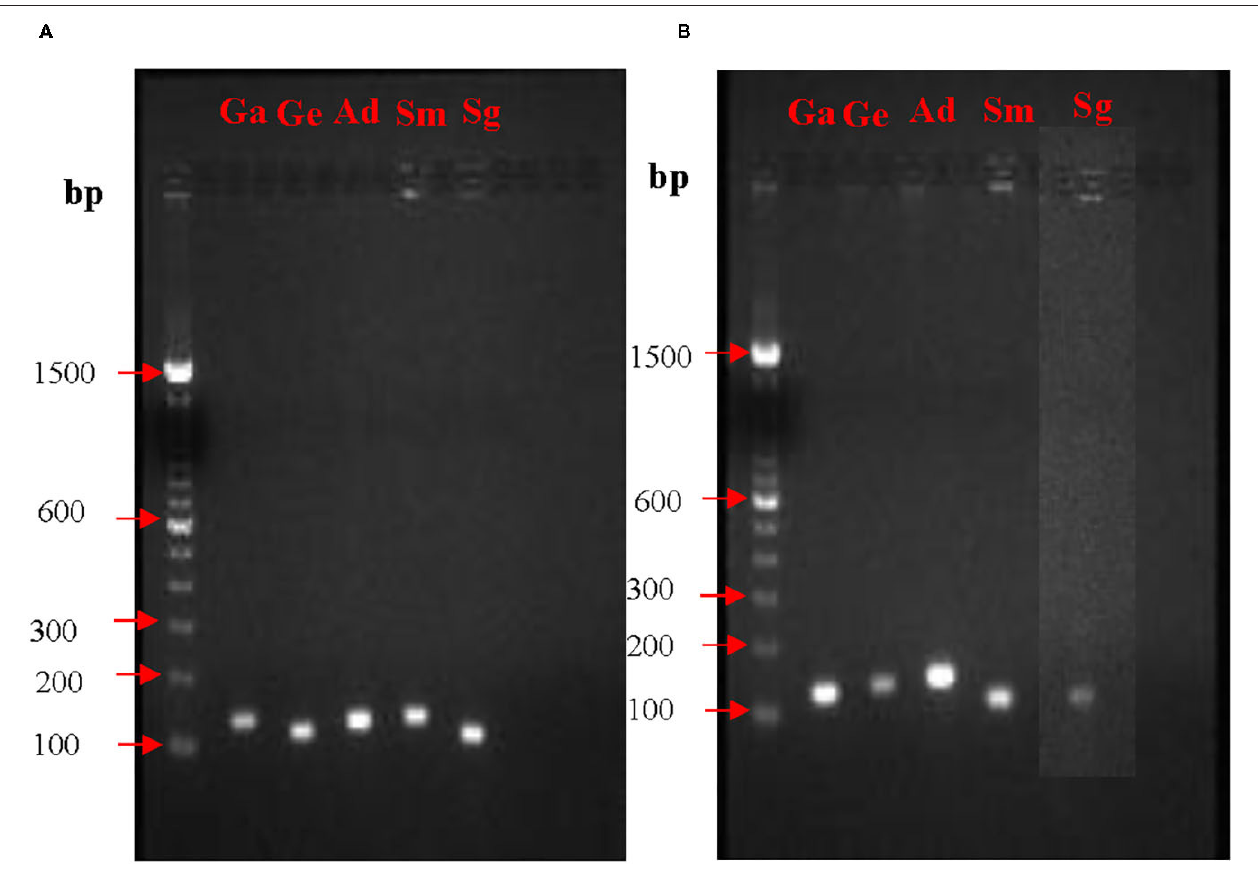
FIGURE 1 | PCR optimization of nox (A) and fbp (B) genes. To confirm the amplification of nox and fbp genes from each strain, PCR and agarose gel electrophoresis were performed prior to RT-PCR experiments. bp, base pair; Ga, G. adiacens ; Ge, G. elegans ; Ad, A. defectiva ; Sm, S. mutans ; Sg, S. gordonii